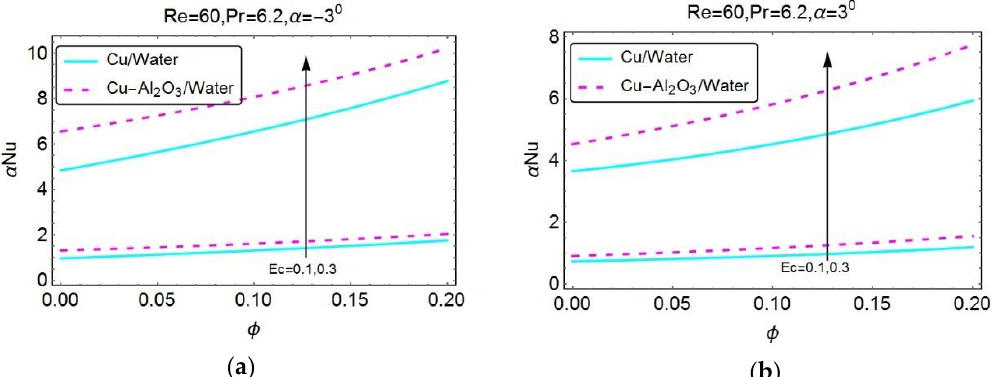
Figure 11. Stimulus of Ec on α Nu: ( a ) convergent case and ( b ) divergent channel.